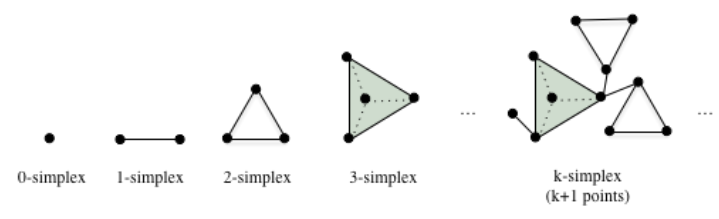
Figure 2. Simplex and simplicial complex.